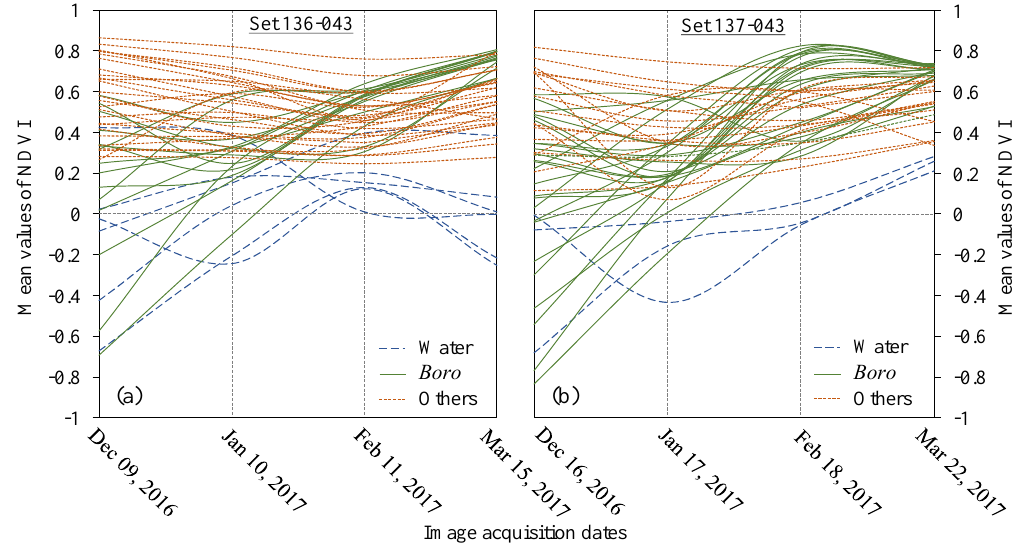
Figure 3. Temporal dynamics of mean NDVI-values of boro , water, and others over the planting to mature season using time-series of Landsat-8 OLI data for the path-row: 136-043 ( a ), and 137-043 ( b ).